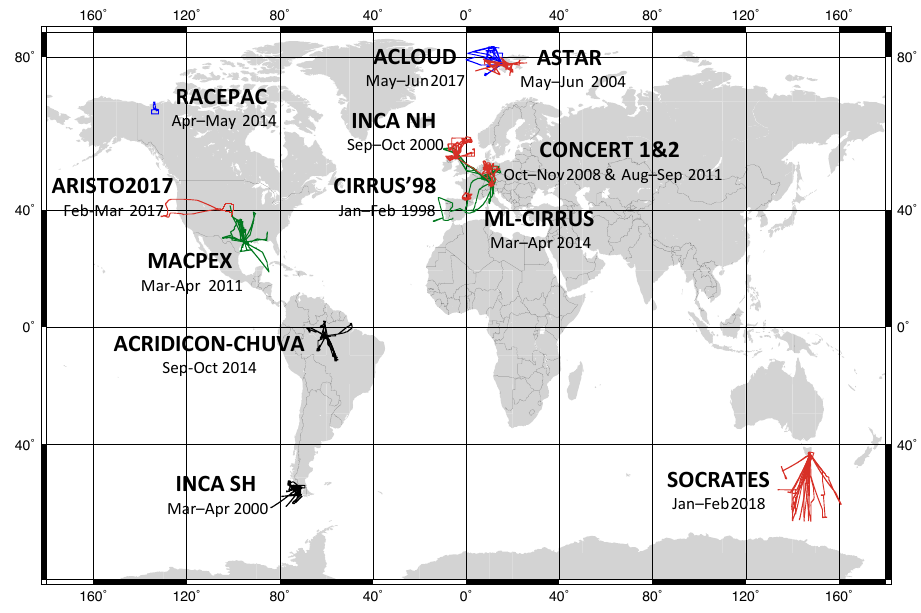
Figure 2. Flight trajectories of all campaigns included in this study. Trajectories of the campaigns where ice crystal mesoscopic complexity was investigated are marked with black, purple and blue matching the colours used in Fig. 3. Trajectories of the campaigns where only angular scattering function was measured are marked with red. Simultaneous mesoscopic complexity measurements and angular scattering measurements were taken in ACRIDICON-CHUVA and ACLOUD